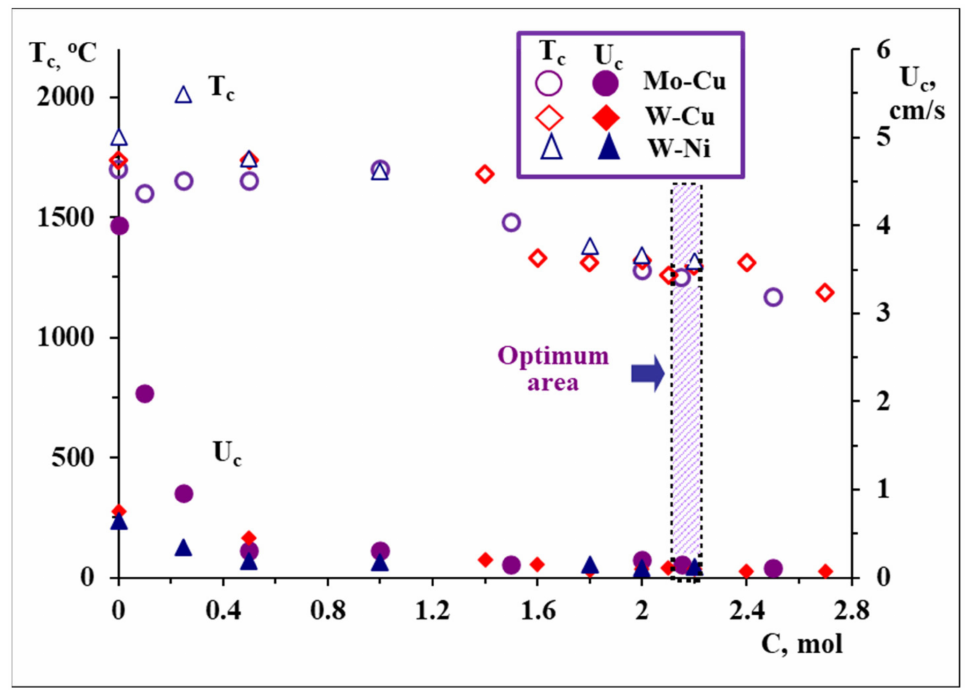
Figure 3. Combustion temperature (T c ) and combustion velocity (U c ) vs. carbon content in